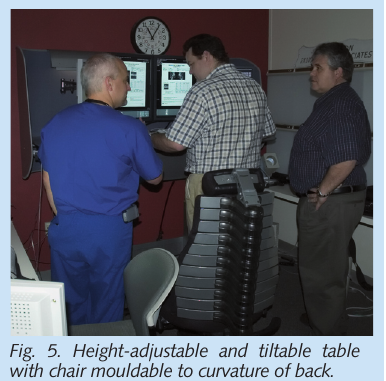
Fig. 5. Height-adjustable and tiltable table with chair mouldable to curvature of back.